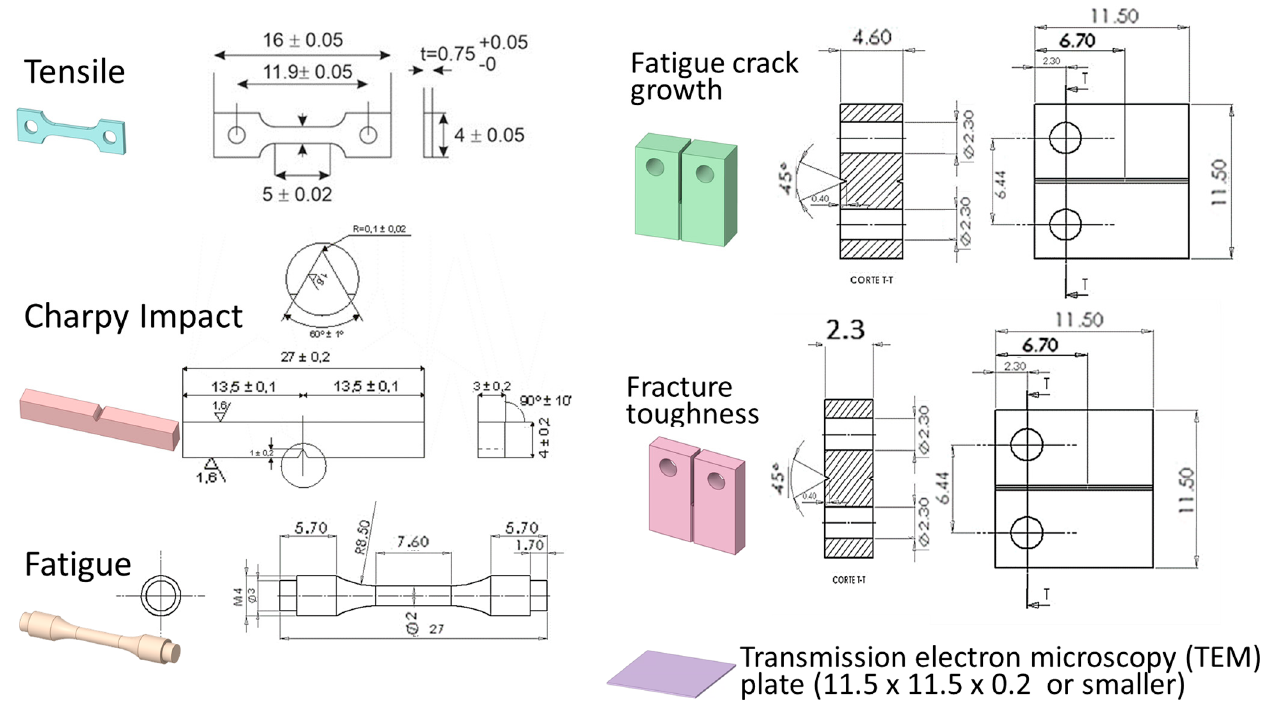
Figure 10. Dimensions (mm) of the SSTT specimens.